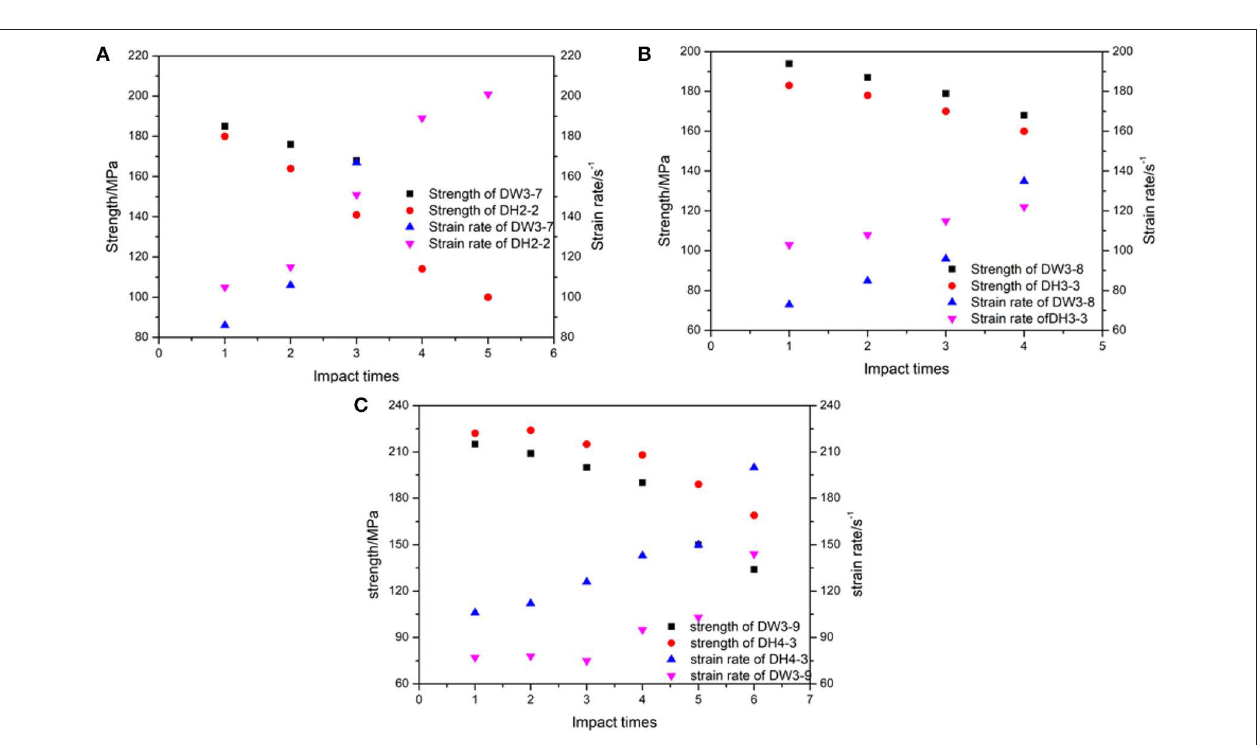
FIGURE 6 | Variation in dynamic strength and strain rate with respect to impact time: (A) confining pressure at 5 MPa, (B) confining pressure at 10 MPa, (C) confining pressure at 12